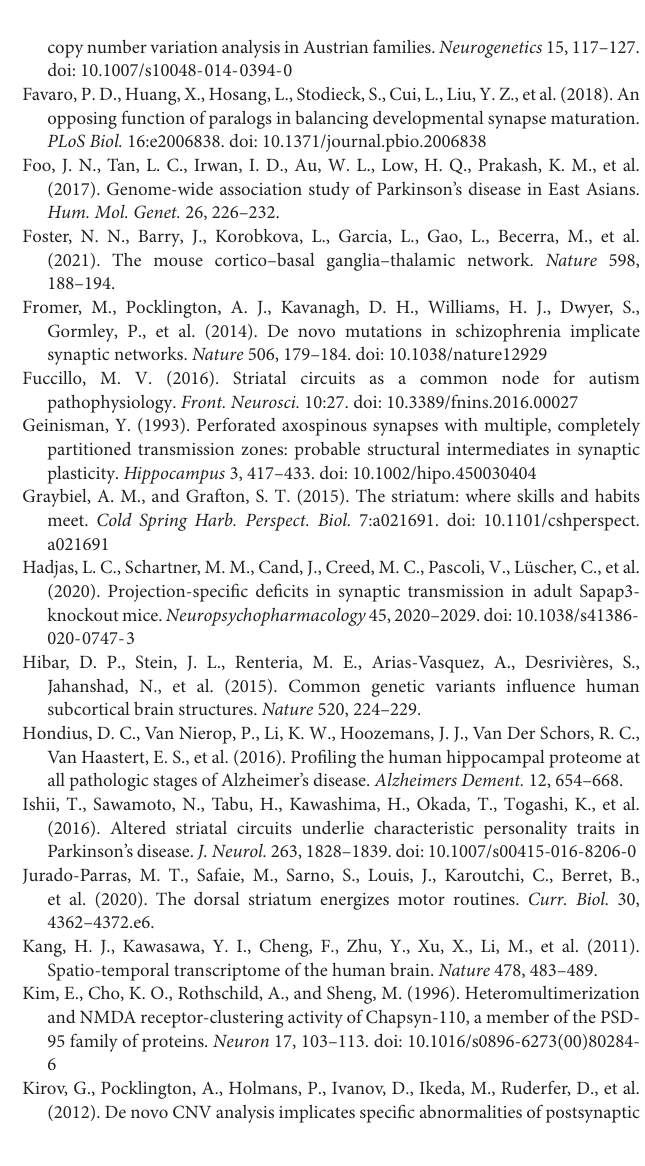
Supplementary Figure 1 | The expression of dopamine D1 and D2 receptors is not altered in the striatum of Dlg2 -/- mice. (A) Representative images of immunohistochemical analysis for the expression of dopamine D1 and D2 receptors (DRD1 and DRD2, respectively) in the striatum of WT and Dlg2 -/- mice. Scale bar, 50 µ m. (B) There was no significant difference in the optical densities of DRD1 and DRD2 in the striatum between groups. A total of 3 sections were used per animal (WT, n = 4, Dlg2 -/- mice, n = 4). (C) Representative immunoblot images of the DRD1 and DRD2 expression in the lysates of the